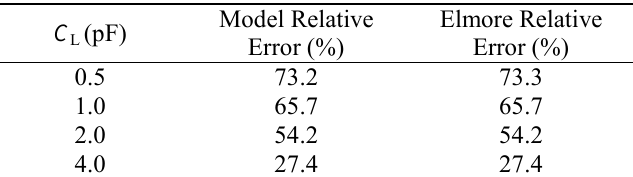
Table 8: Relative error between the 50%-propagation delay computed with the proposed model and the Elmore one versus load C L for the case